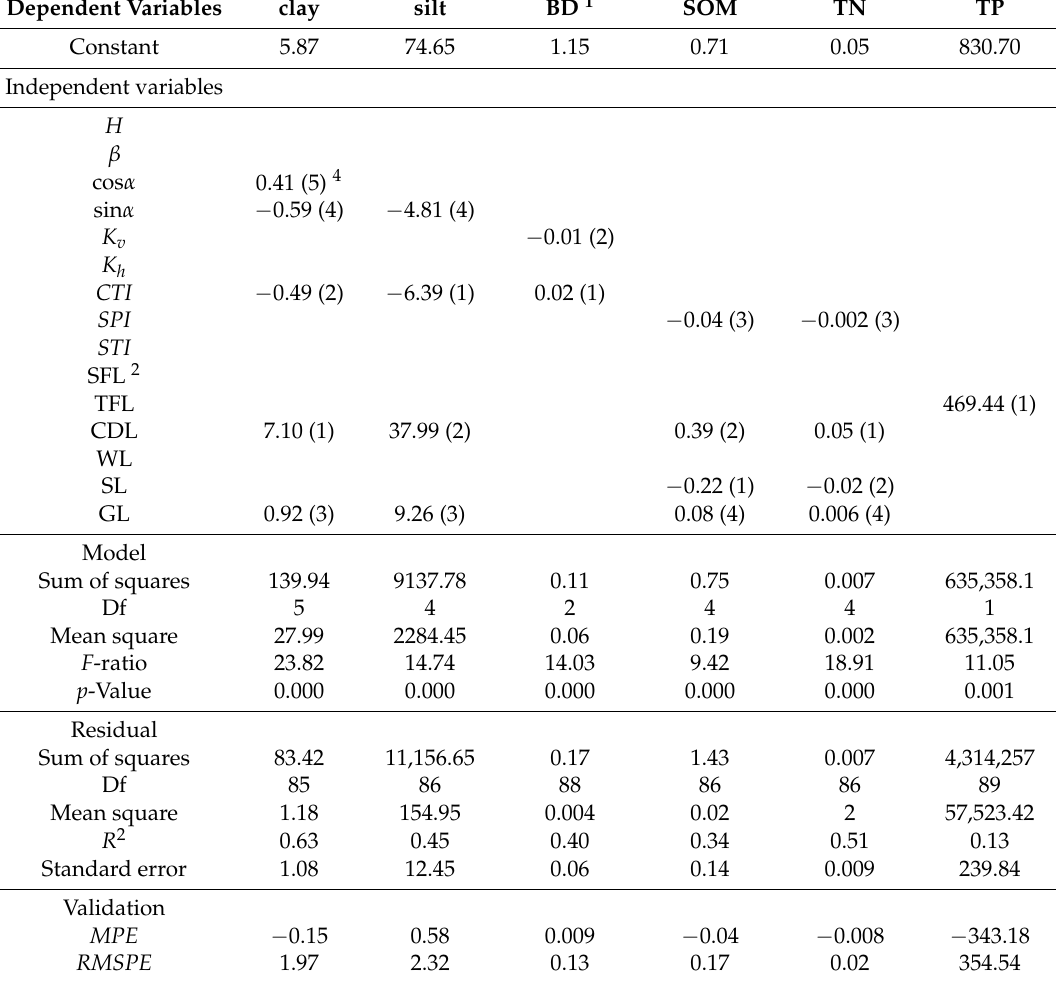
Table 6. Stepwise multiple regression function for each soil property.